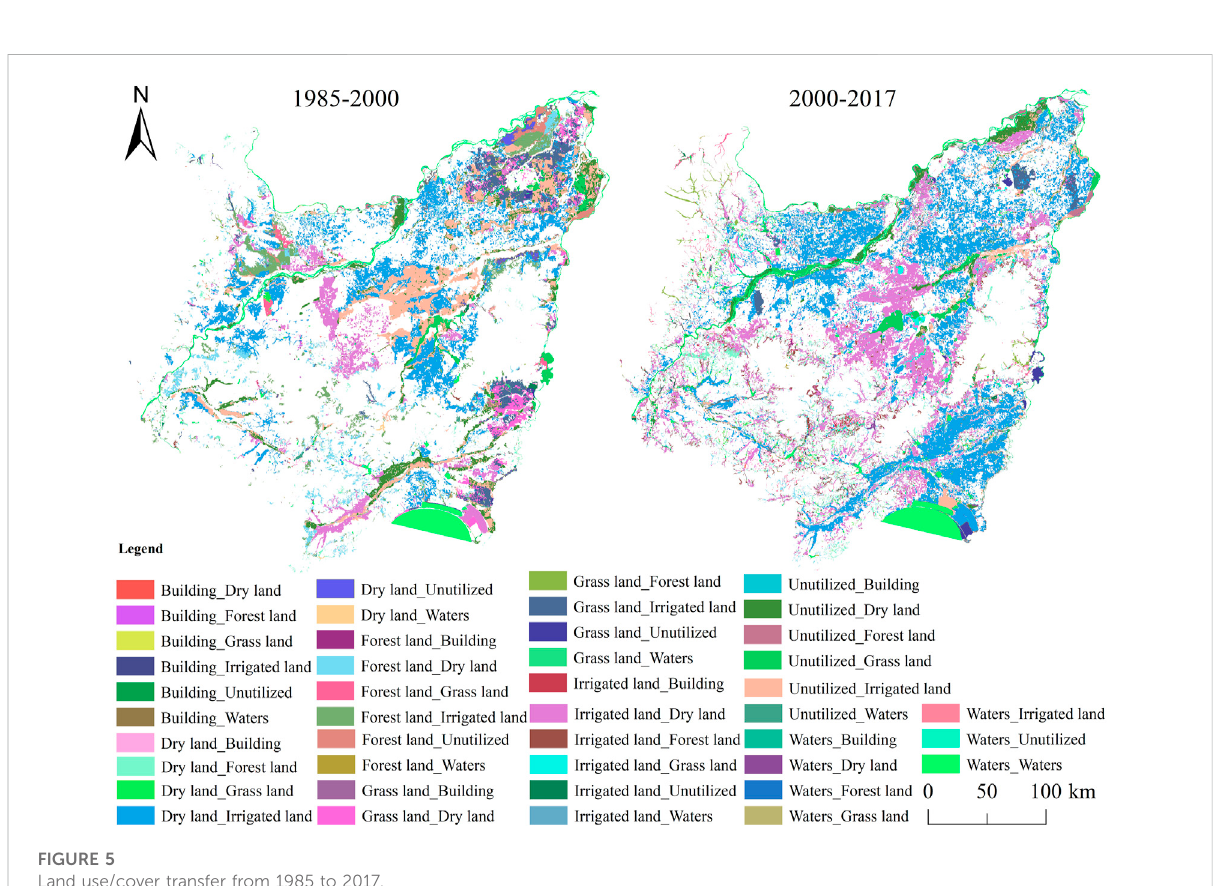
FIGURE 5 Land use/cover transfer from 1985 to